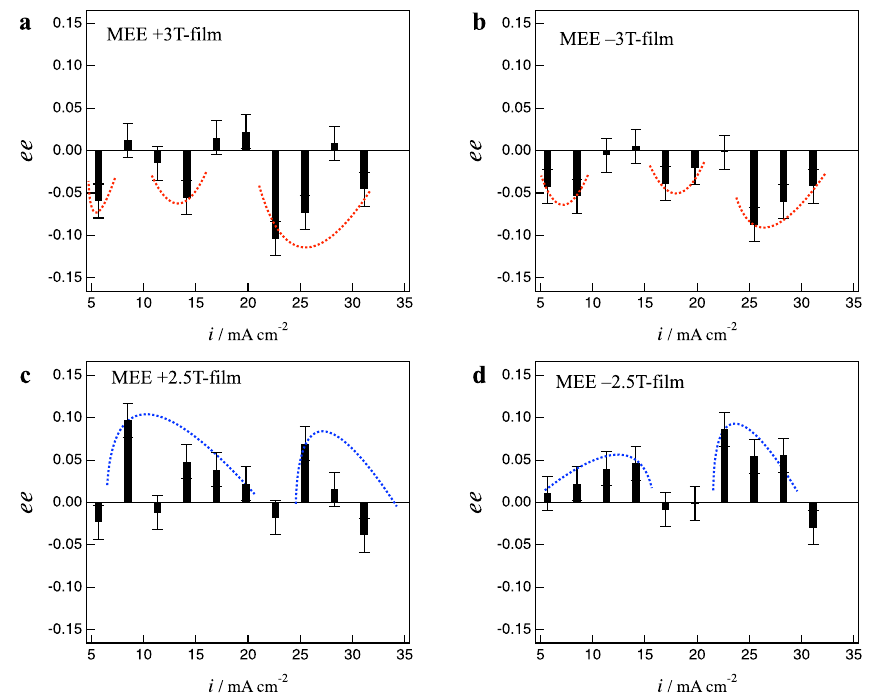
Figure 6. The ee ratios vs. etching currents. ( a ) MEE + 3T-film, ( b ) MEE − 3T-film, ( c ) MEE + 2.5T-film and ( d ) MEE − 2.5T-film. Dotted curves are a guide for the eye.